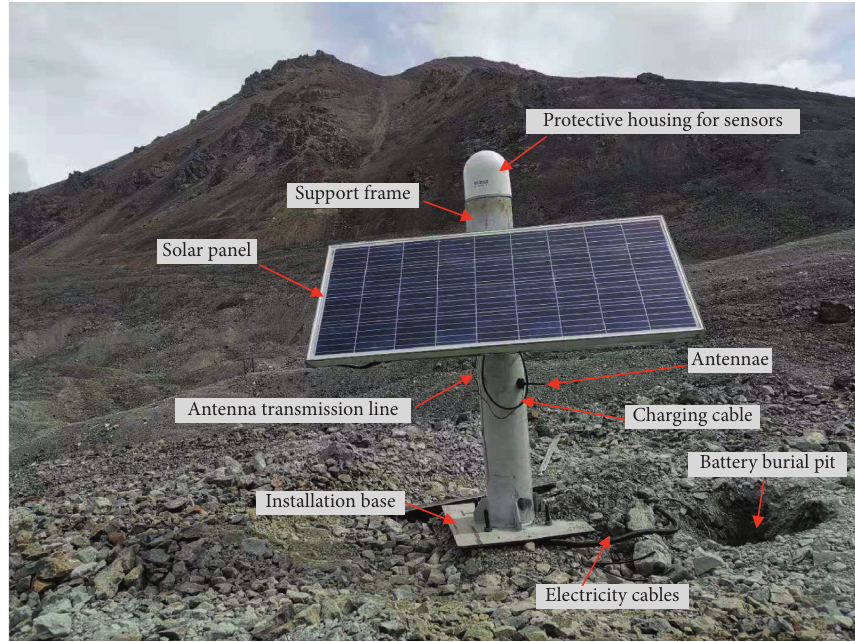
Figure 2: GNSS ground deformation monitoring